Question: What visual encoding does this figure use to show its data?
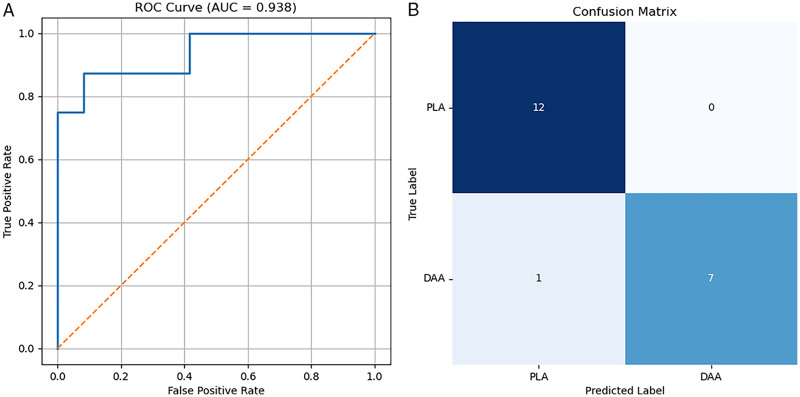
Answer: heatmap